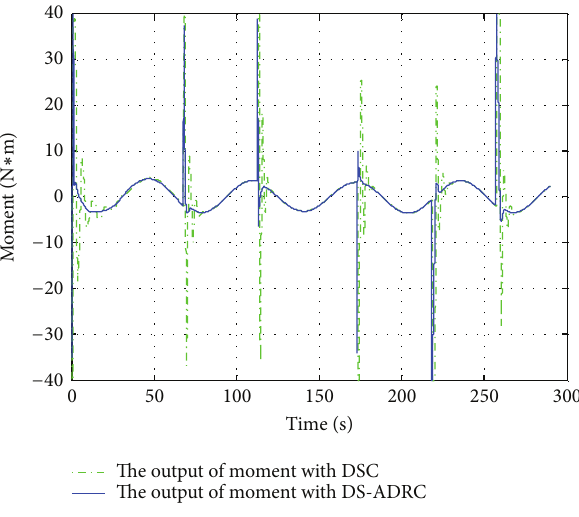
Figure 11: The output of